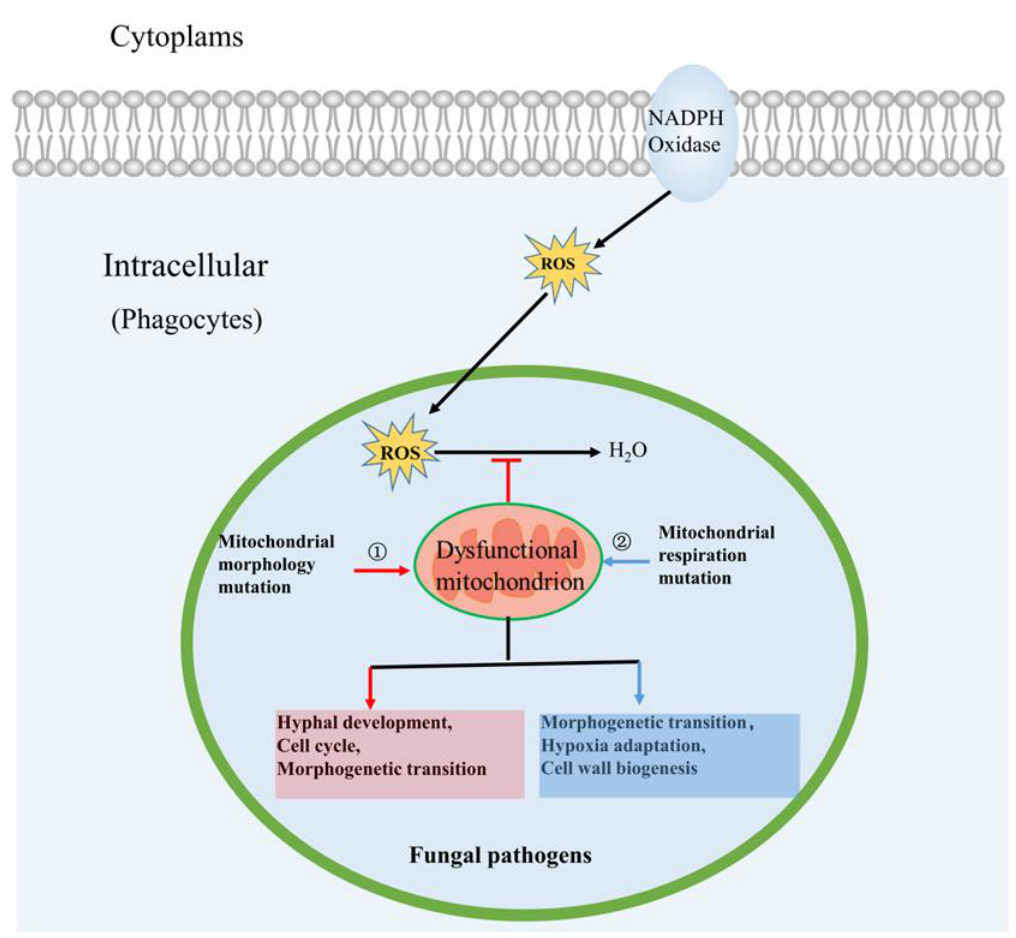
Figure 4. Roles of mitochondria in fungal pathogenicity: 1 (cid:79) Mitochondrial morphology influences fungal pathogenicity. 2 (cid:79) Mitochondrial respiration influences fungal